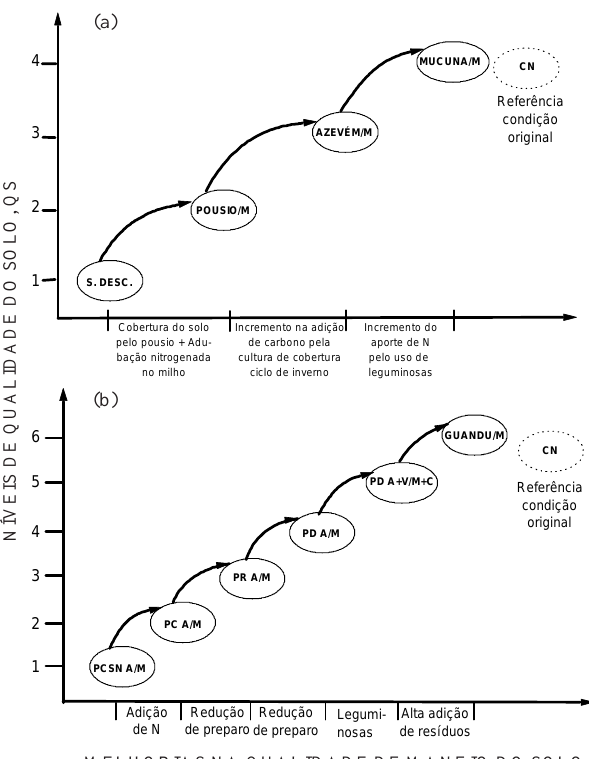
Figura 1. Sistema de organização teórico proposto para a ordenação da QS nas áreas experimentais da UFSM (a) e UFRGS (b). PC = Preparo convencional; PD = Plantio direto; A = aveia preta; M = milho; V = vica; C = caupi e CN =campo